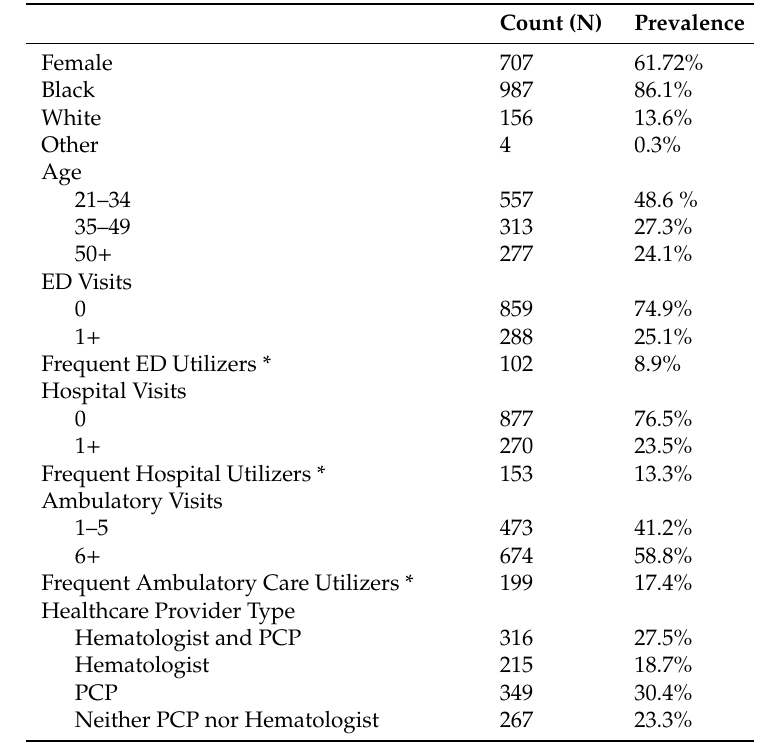
Table2. Characteristicsofthepatientswithsicklecelldisease(SCD)intheOneFloridaDataTrustdataset.